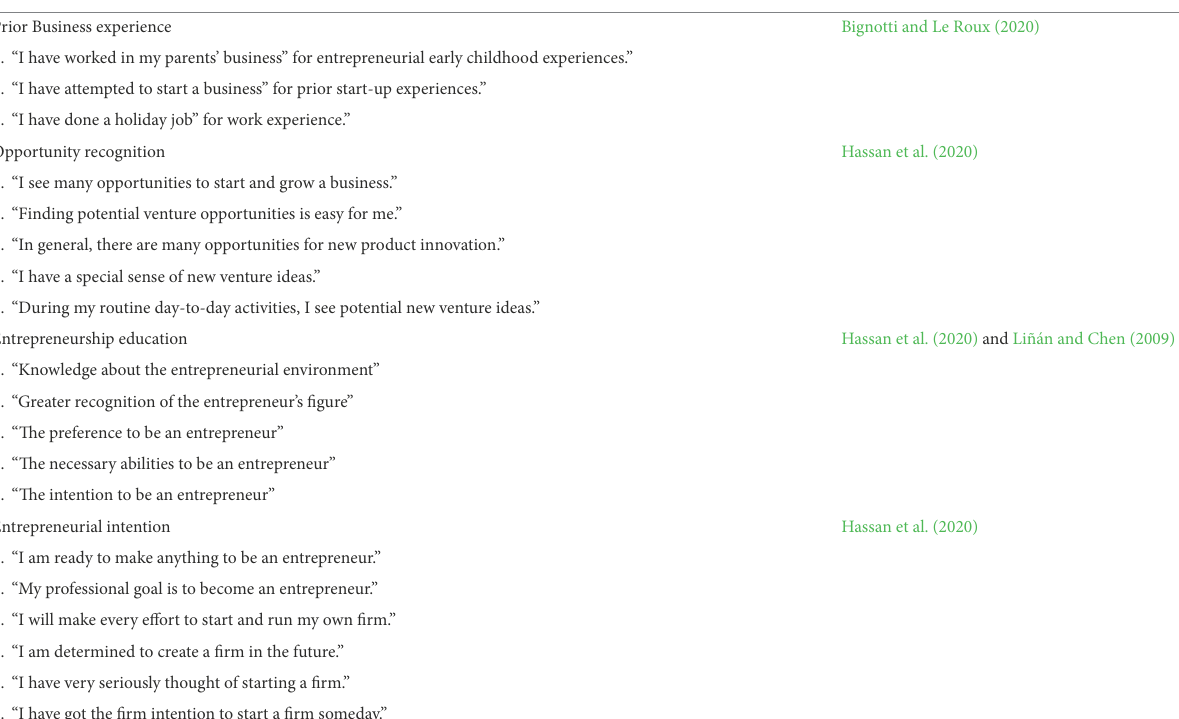
TABLE 1 Items of measurement. Items of measurement